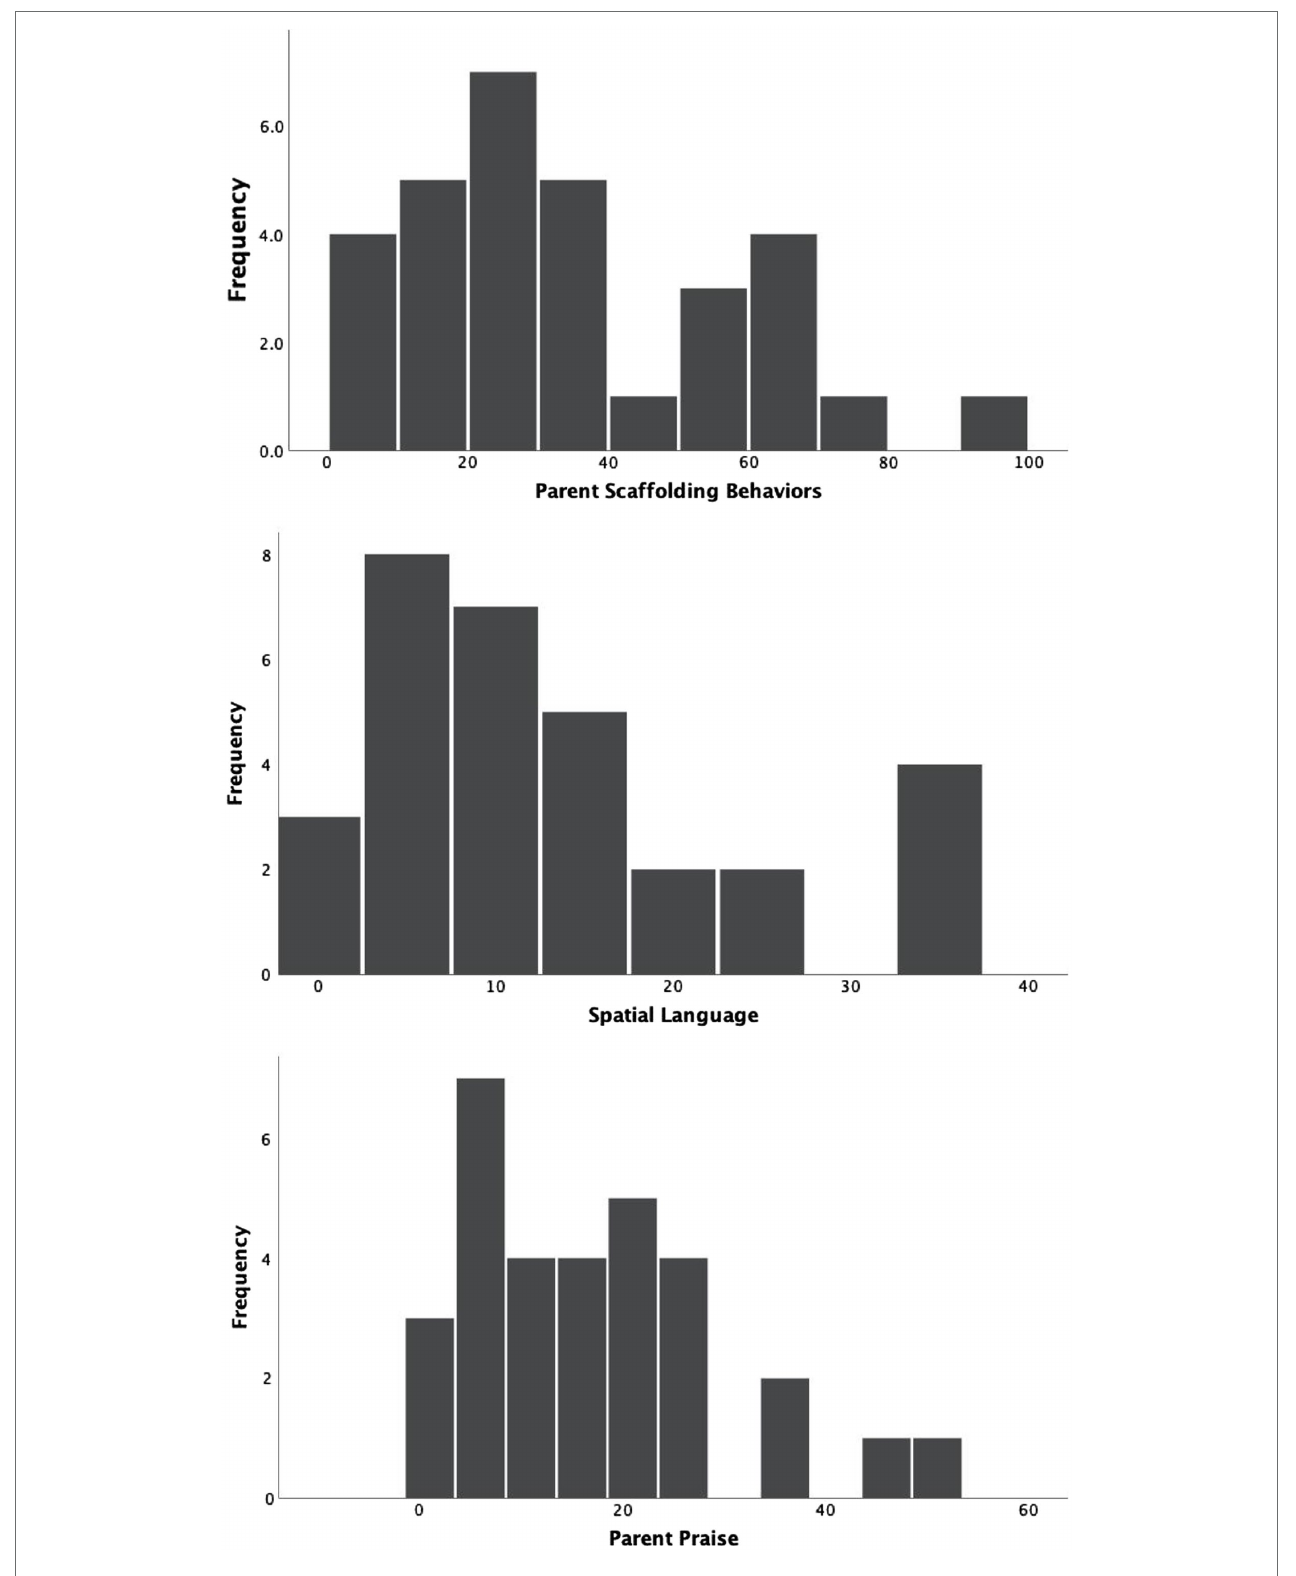
FIGURE 4 | Distribution of parent